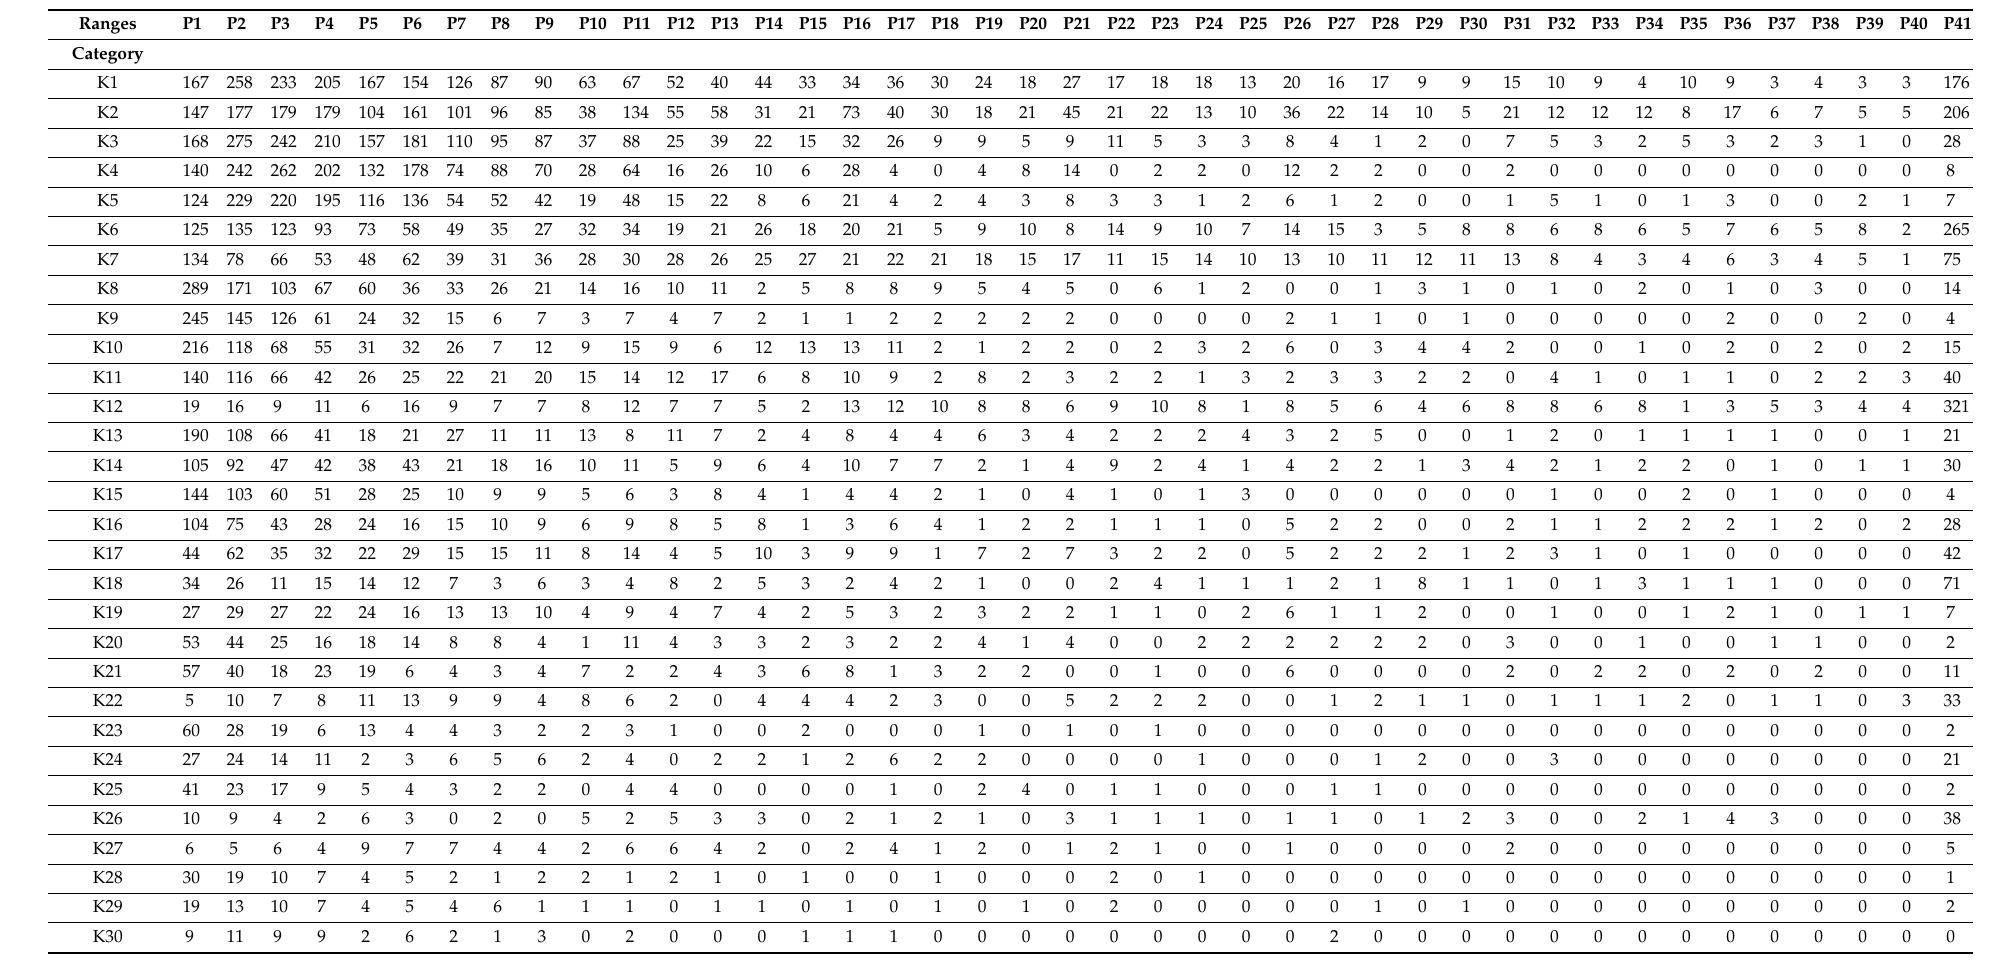
Table 7. Numerical input data in terms of project profitability